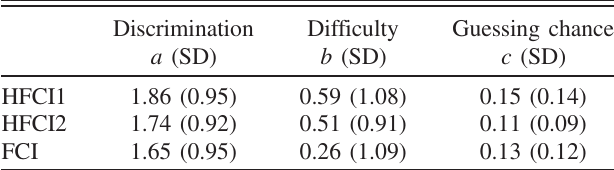
TABLE III. Assessment parameters for the two half-length tests and the full-length FCI calculated using IRT model applied on the pretest